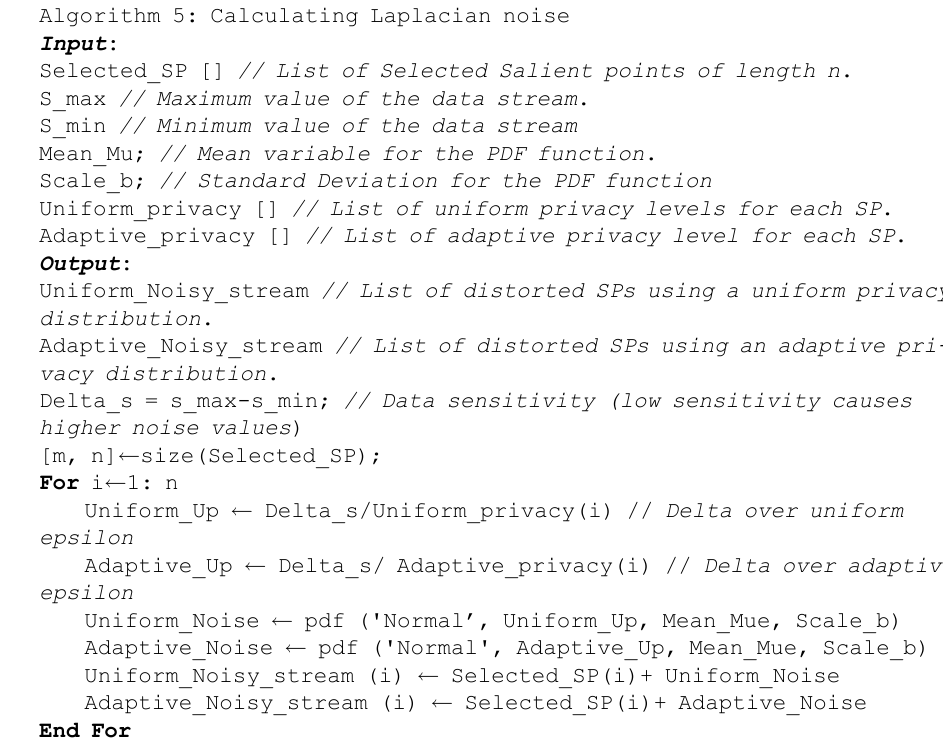
Algorithm 5: Calculating Laplacian